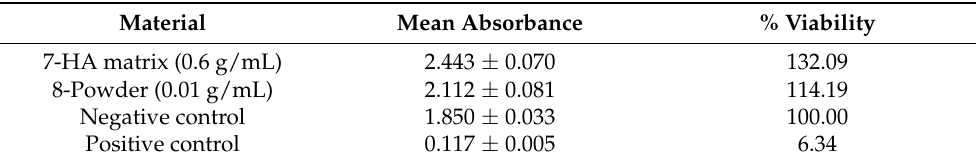
Table 1. Data for MTT test.